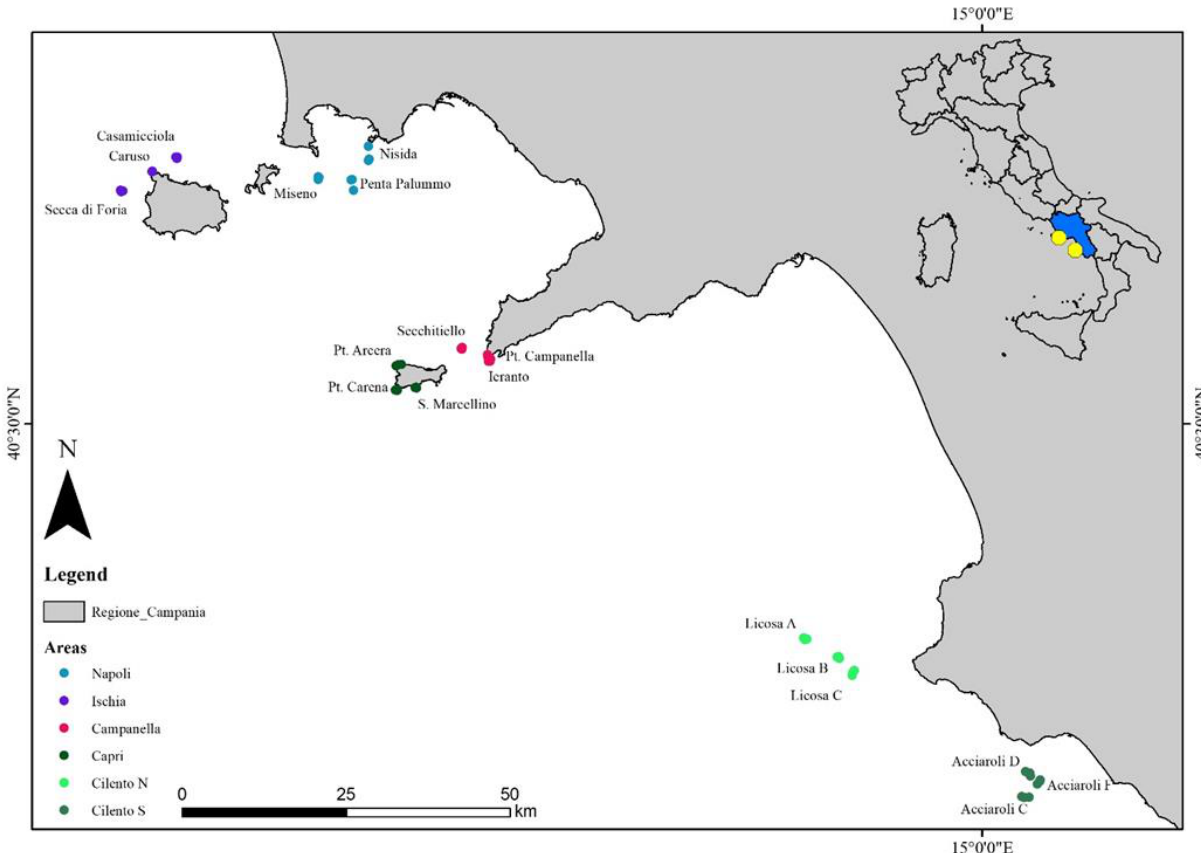
Figure 1. Study areas with sampling sites.